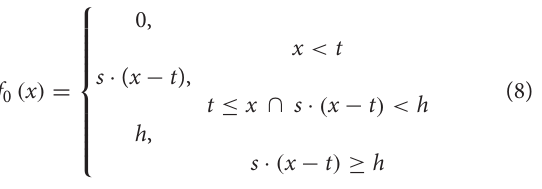
(cf. Hubara et al., 2016)—instead of the generalized logistic function for fitting f 0 ( x ) , thereby eliminating the arbitrary parameter p and decoupling the lower and upper end of the dynamic